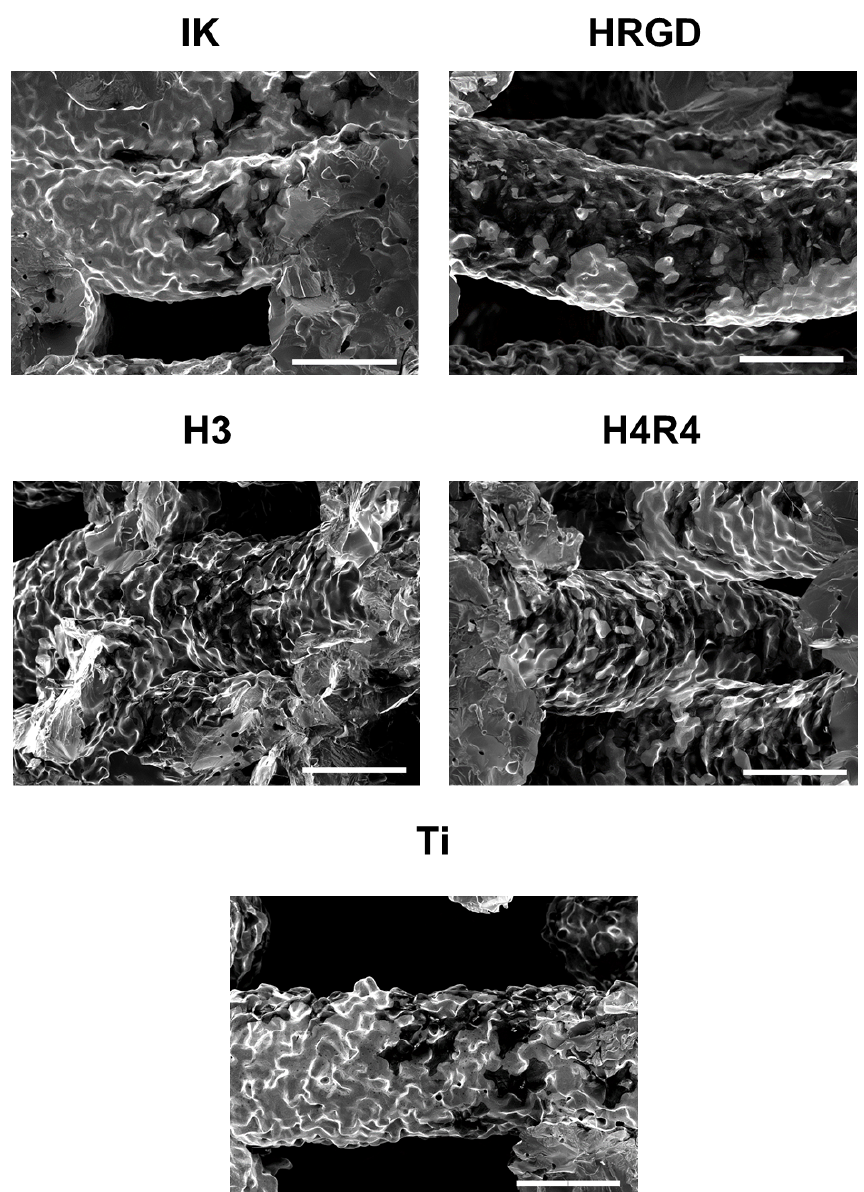
Figure 7. Representative SEM images of the different functionalized and non-functionalized Ti scaffolds showing attached cells 4 h after cell seeding. Scale bars denote 200 μ m.